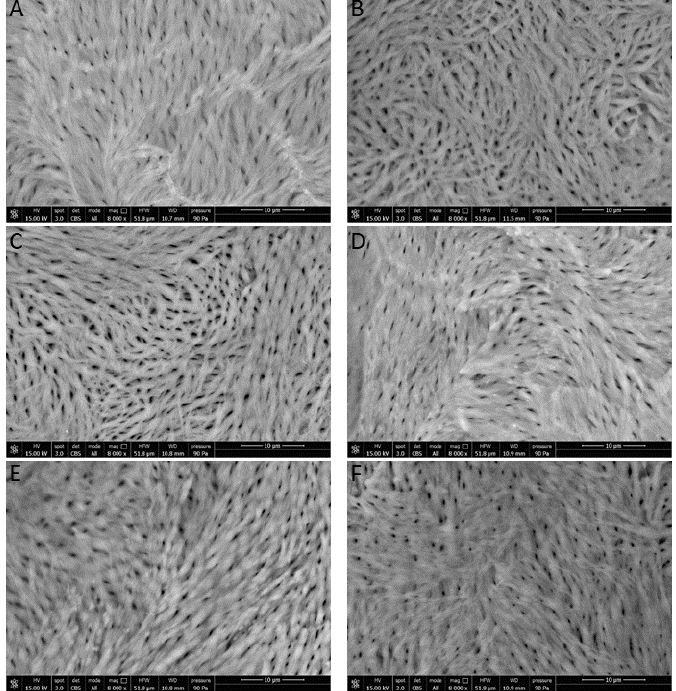
Figure 7. SEM images of inner rat femur: ( A ) sham; ( B ) ova; ( C ) CaCl 2 0.5 g; ( D ) CaCl 2 1.0 g; ( E ) Granule 0.5 g; ( F ) Granule 1.0 g.